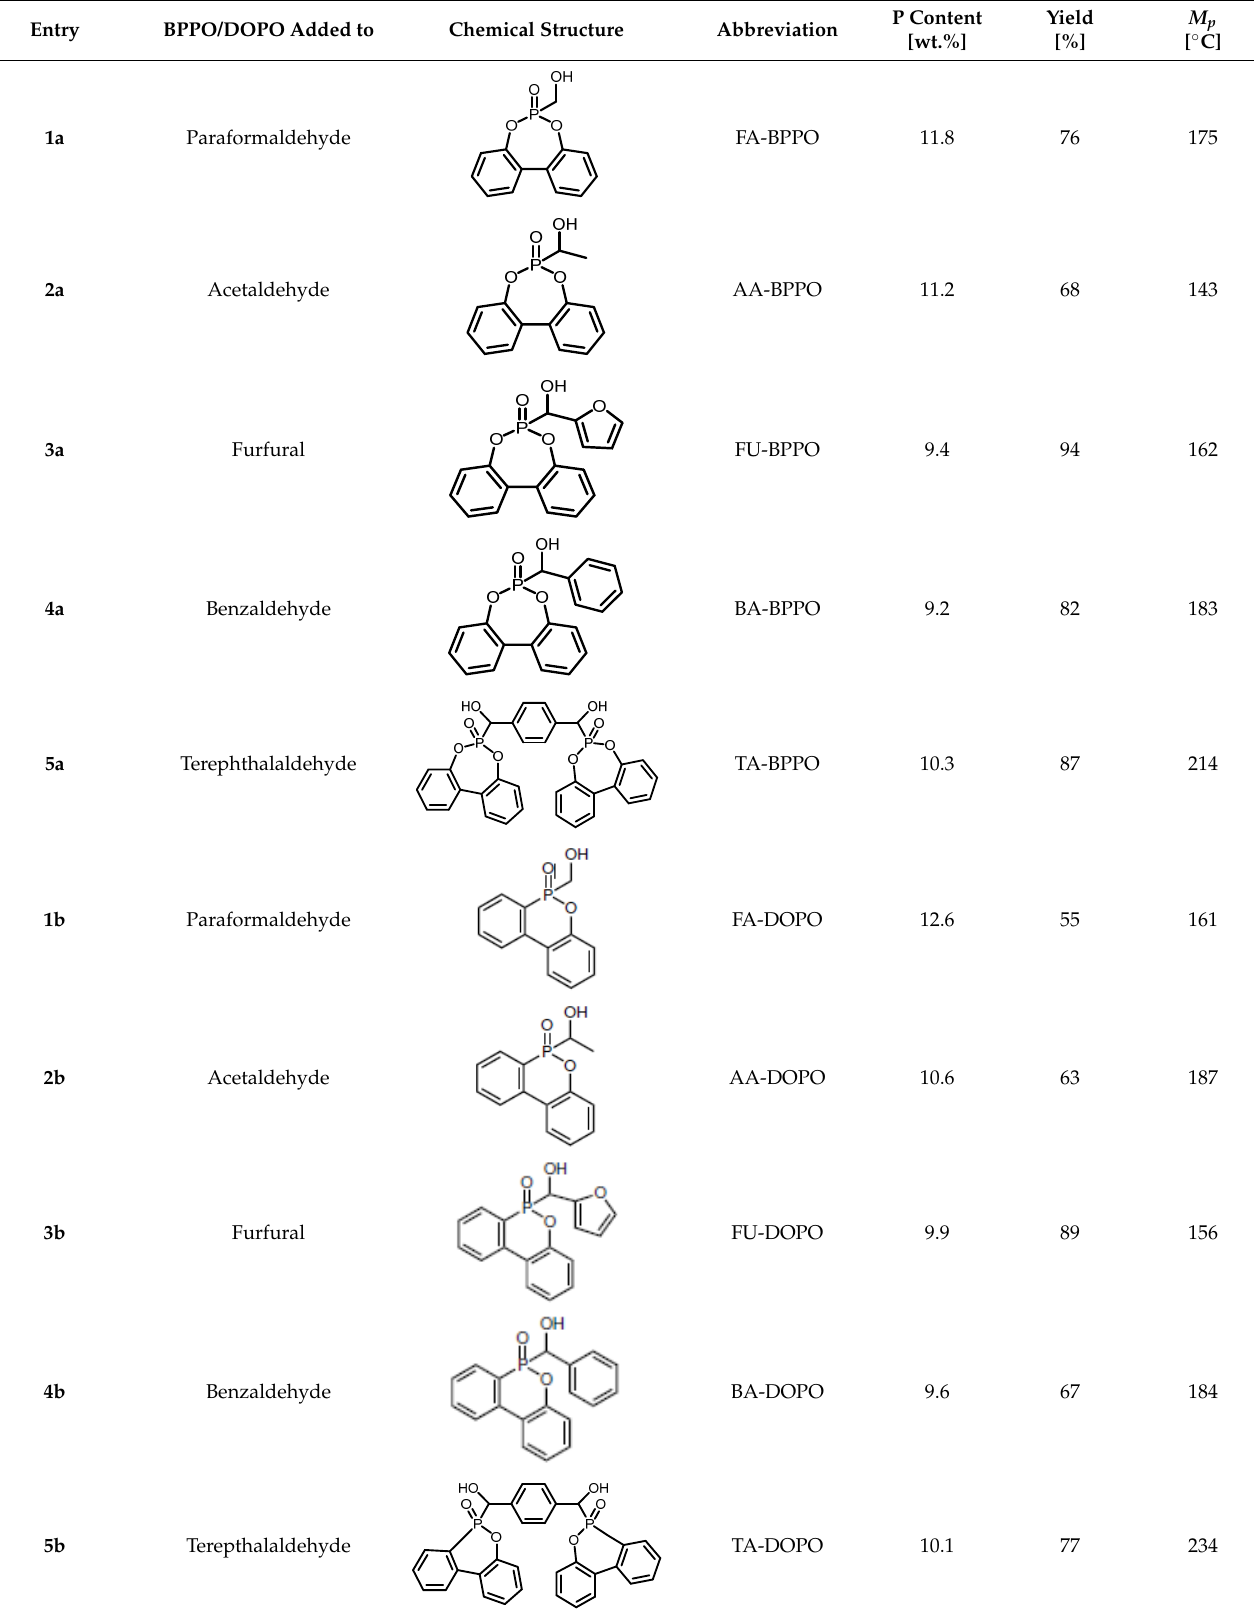
Table 1. BPPO and DOPO adducts synthesized by phospha-aldol reaction and studied as FR in PUR/PIR foams: chemical structure, abbreviation, and yield.